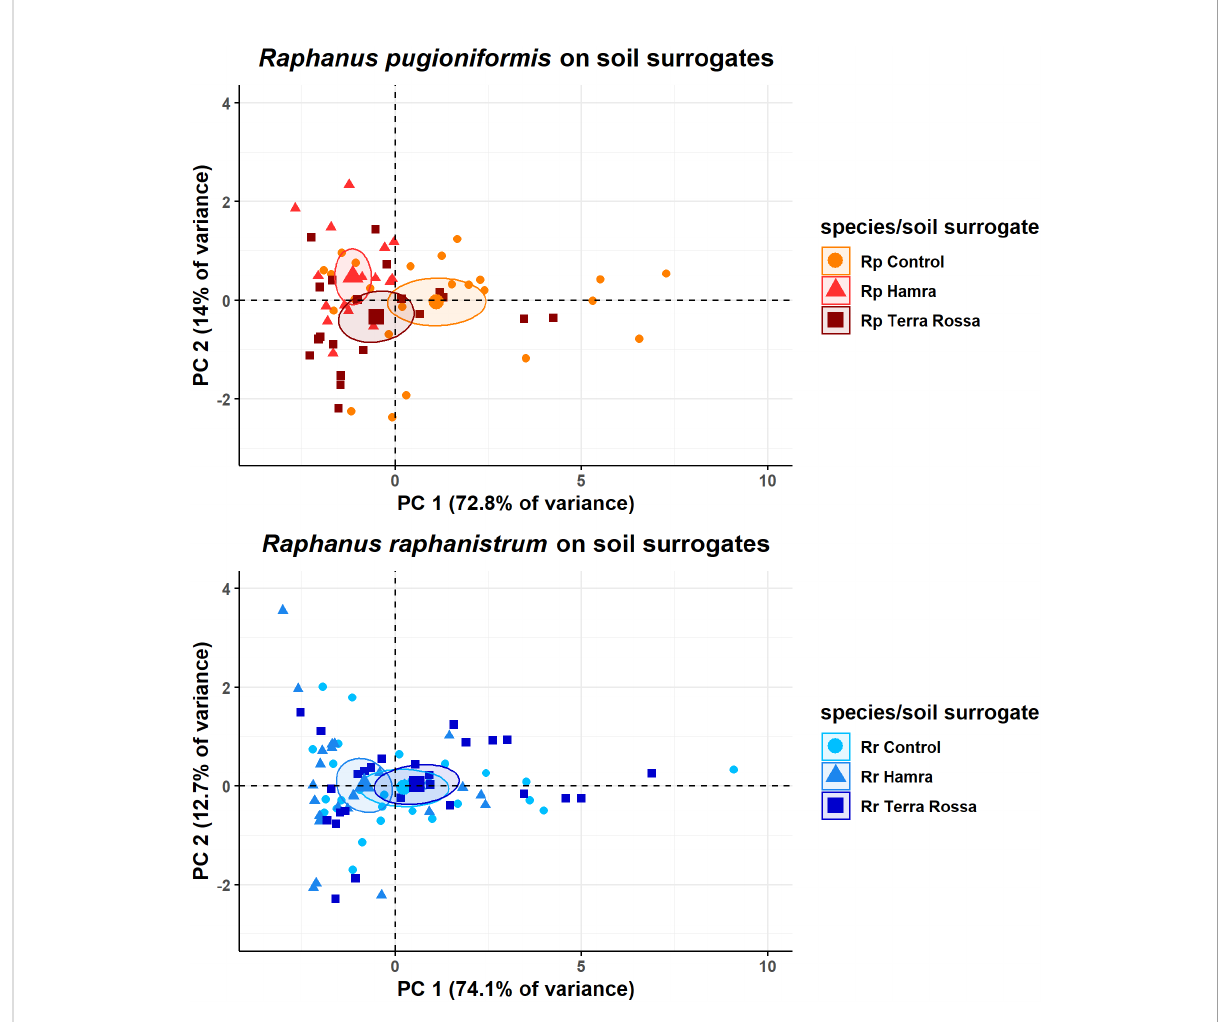
FIGURE 7 Dimensional reduction of seven root architecture parameters revealed greater modulation of lateral root length and number is required by R. pugioniformis than by R. raphanistrum to adapt to diverse soil types. PCA analysis of seven root parameters from R. pugioniformis and R. raphanistrum grown on three different soil surrogates over three weeks (126 samples in total). Soil surrogates represent nutrient solutions, mimicking the natural soils of R. raphanistrum and R. pugioniformis , i.e., Hamra and Terra Rossa, the third solution is a control. Principal component 1 separates the groups by length of different root types and the number of lateral roots, component 2 mainly by main root angle, together they include 85% of the total information content derived from the measured variables (main root length, main root vector, main root angle, total root length, lateral roots on main root, total number of lateral roots and lateral root length). The ellipses show the 95% con fi dence